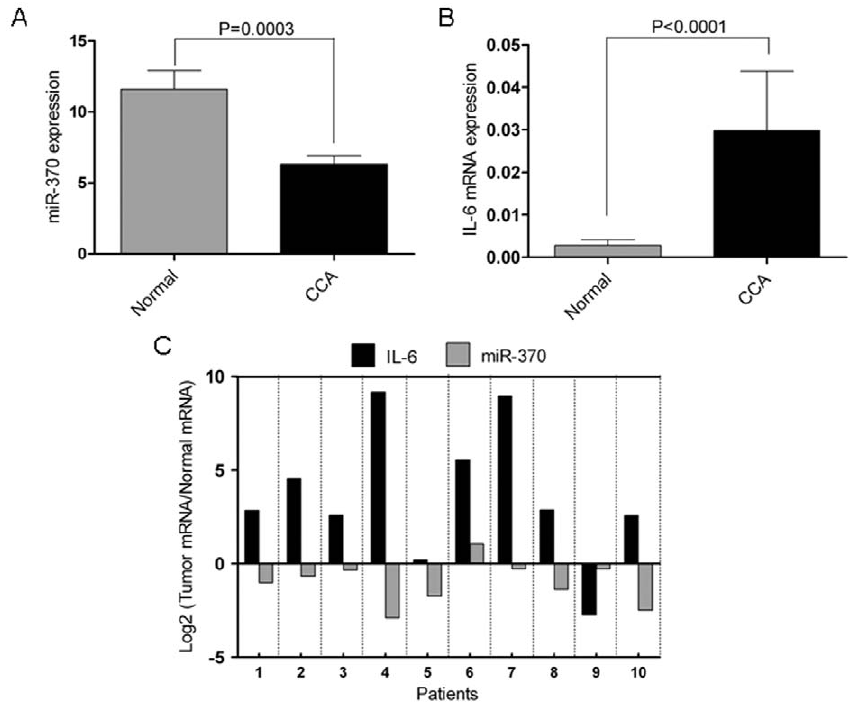
Figure 1. miR-370 and IL-6 are inversely correlated in human CCA. A. miR-370 is downregulated in human CCA vs. normal liver tissues. The figure displays the mean and standard deviation of qRT-PCR-measured expression of miR-370 normalized to RNU6B for human CCA and normal liver tissues. B. IL-6 is upregulated in human CCA vs. normal liver tissues. The figure displays the mean and standard deviation of qRT- PCR-measured expression of IL-6 mRNA normalized to b -actin for human CCA and normal liver tissues. C. miR-370 and IL-6 display an inverse relationship in matched human CCA and normal specimens. Ten pairs of CCA and matched normal liver tissues for which we had expression data for both miR-370 and IL-6 were analyzed. For each CCA specimen, we compared the level of miR-370 and IL-6, respectively, to their corresponding normal specimen. The figure displays the Log2 of the ratio of miR-370 in CCA vs. matched normal as well as the Log2 of the ratio of IL- 6 in CCA vs. matched normal specimen. Since the data is displayed in log space, a positive value on the Y-axis for miR-370 or IL-6 represents overexpression of miR-370 or IL-6, respectively, in a CCA specimen vs. matched normal specimen. Conversely, a negative value on the Y-axis represents underexpression of miR-370 or IL-6, respectively, in the CCA specimen vs. matched normal specimen. The X-axis displays the 10 pairs of